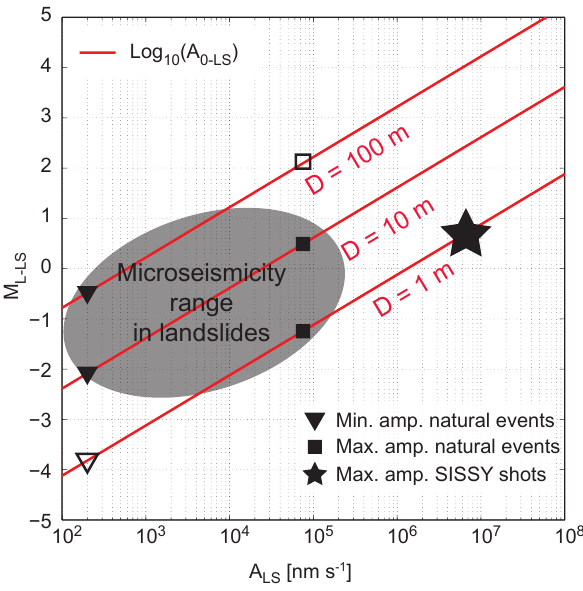
Figure 13. M L − LS as a function of amplitude reads at 1, 10 and 100m source–receiver distances. The star indicates the average maximum amplitude read of SISSY calibration shots at 1m of dis- tance that corresponds to M L − LS 0.58. Minimum and maximum signal amplitudes observed for landslide-induced signals are sym- bolized by triangles and squares, respectively. Empty symbols indi- cate lower probability valid distances of low and high amplitude val- ues. A reasonable field of the potential M L − LS of landslide-induced microseismic events is outlined by the shaded